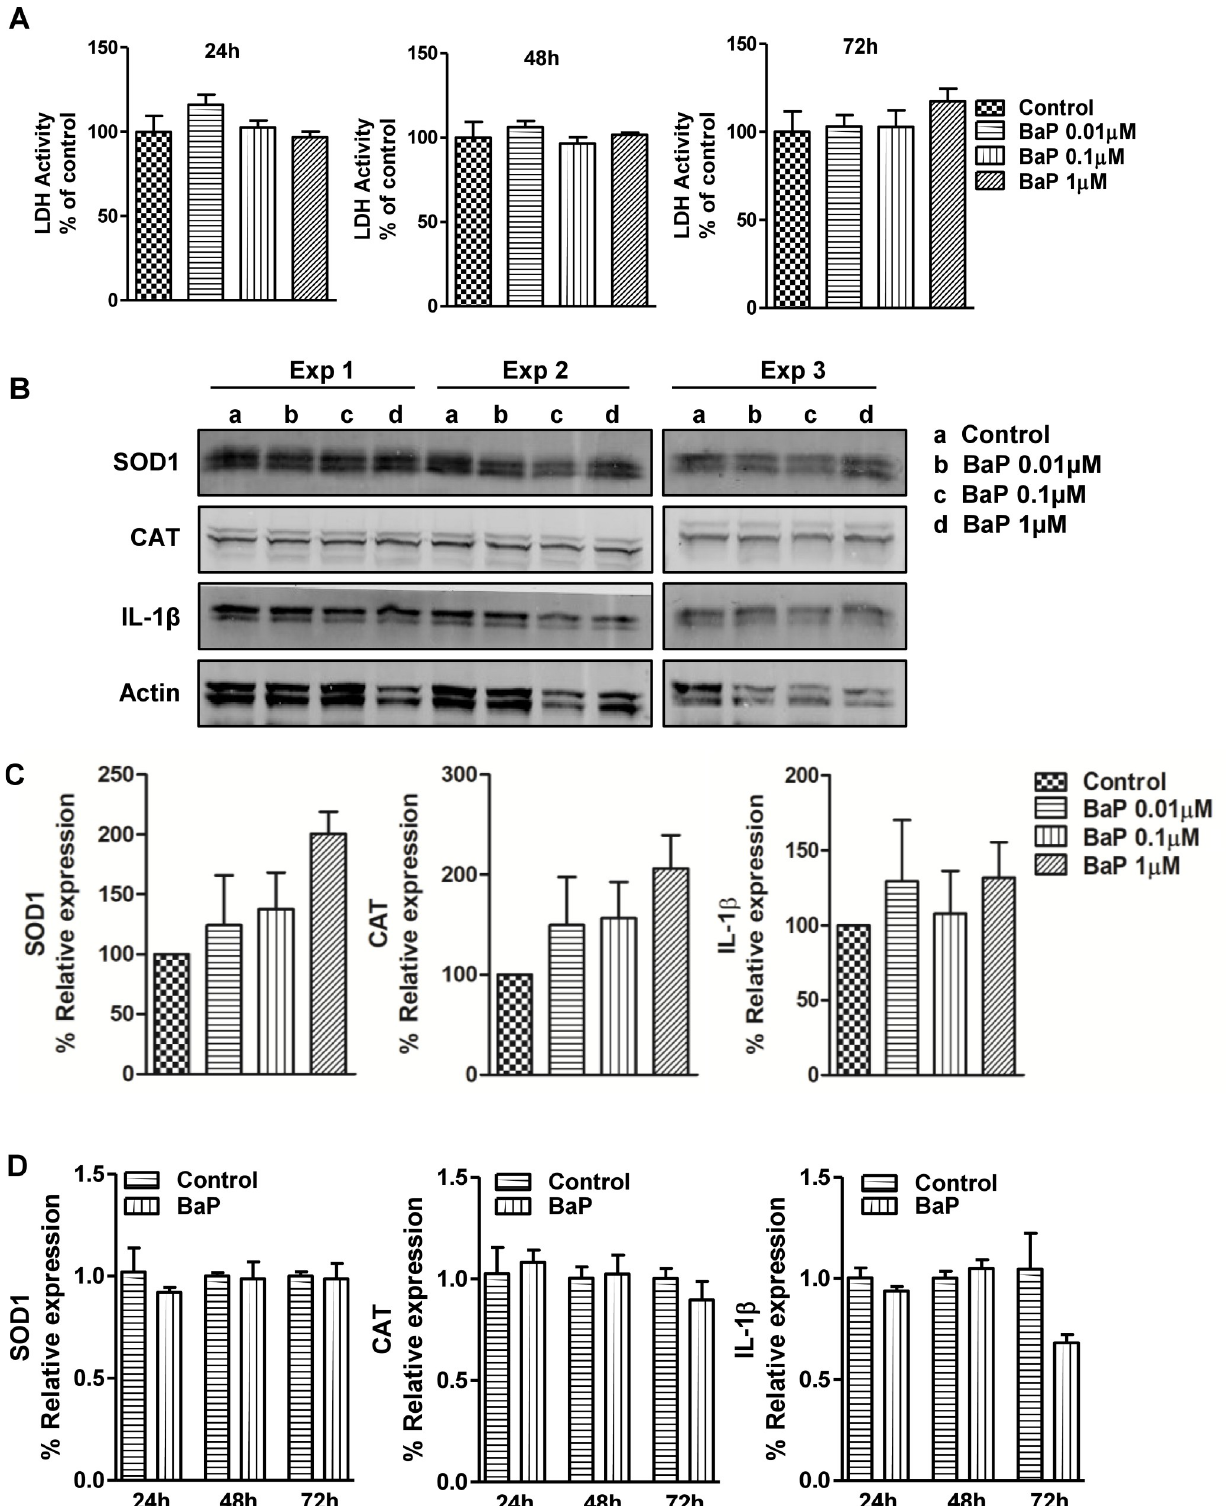
Fig 1. LDH activity and protein expression of AOEs and cytokine IL-1 β (A, B). (A) LDH activity was performed in U1 cells treated with different concentrations of BaP (daily treatment up to 72 h). (B) Representative Western blots of AOEs (SOD1 and CAT) and IL-1 β in U1 cells (Western blot at 72